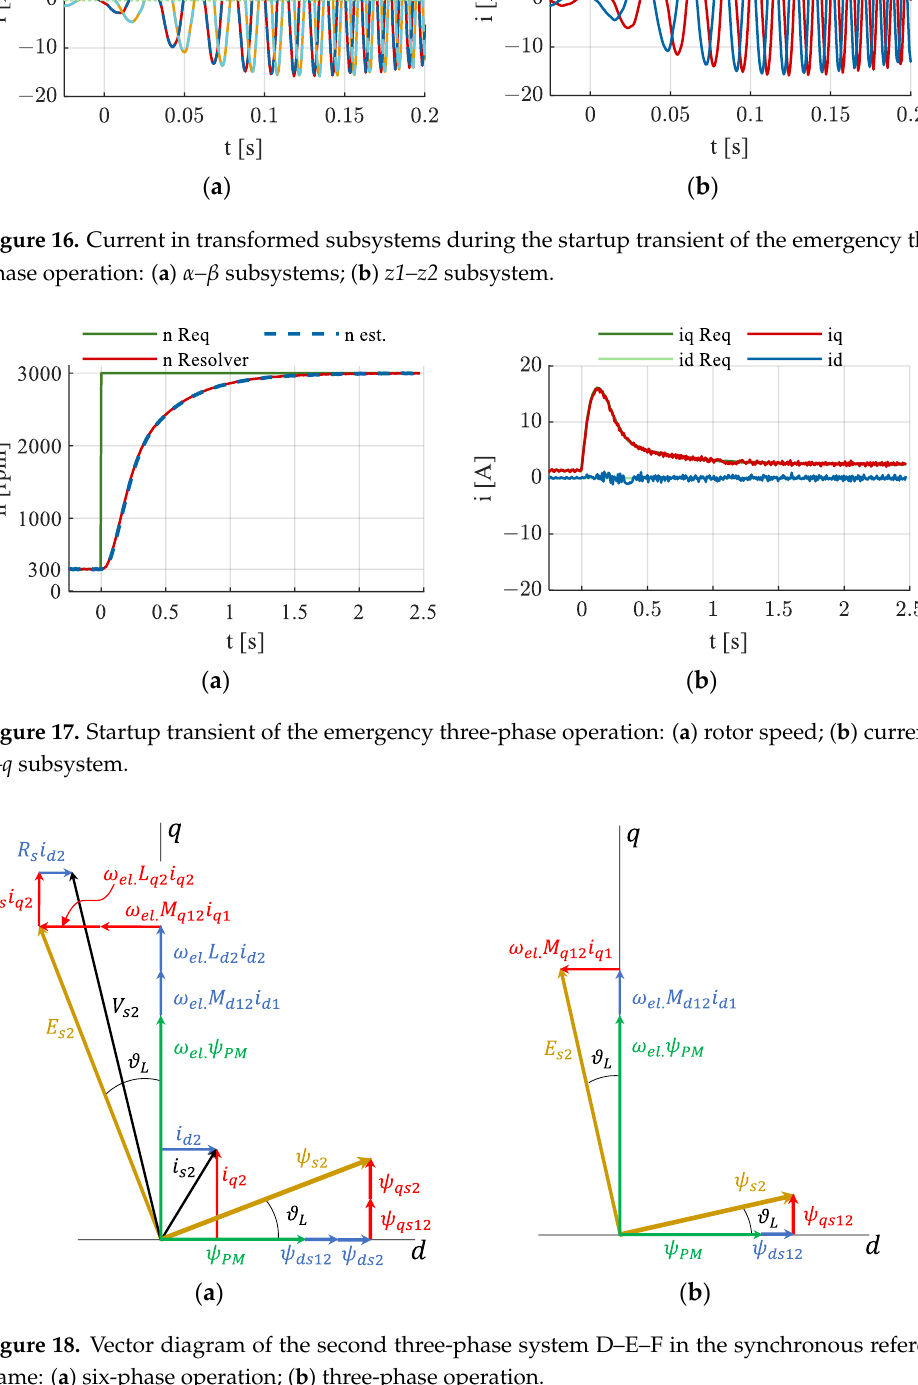
Figure 16. Current in transformed subsystems during the startup transient of the emergency three-